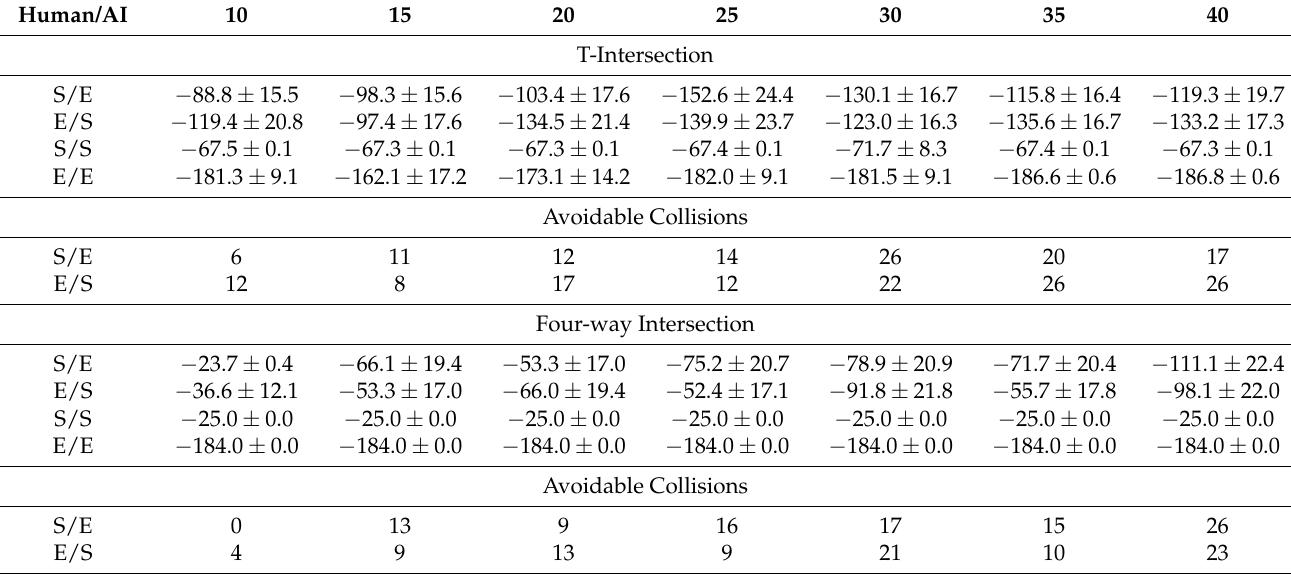
Table 17. Mean rewards and avoidable collision counts (by human–AI configuration) for a random manager with given delegation interval lengths in the human: weather, AI: sensor and mask case.